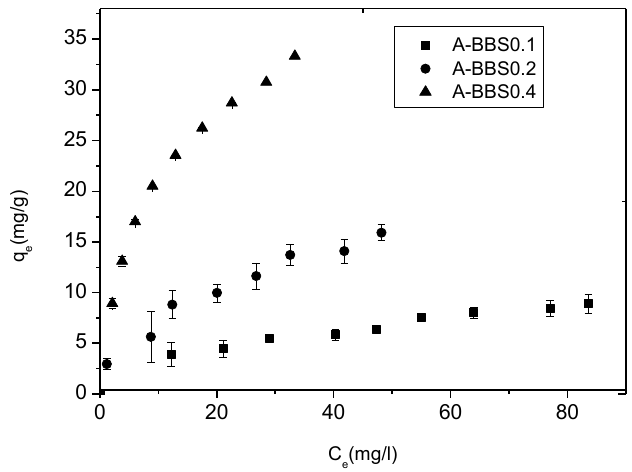
Figure 6. Equilibrium isotherms for the adsorption of CV by di ff erent hybrid adsorbents in MilliQ water at 15 °C.